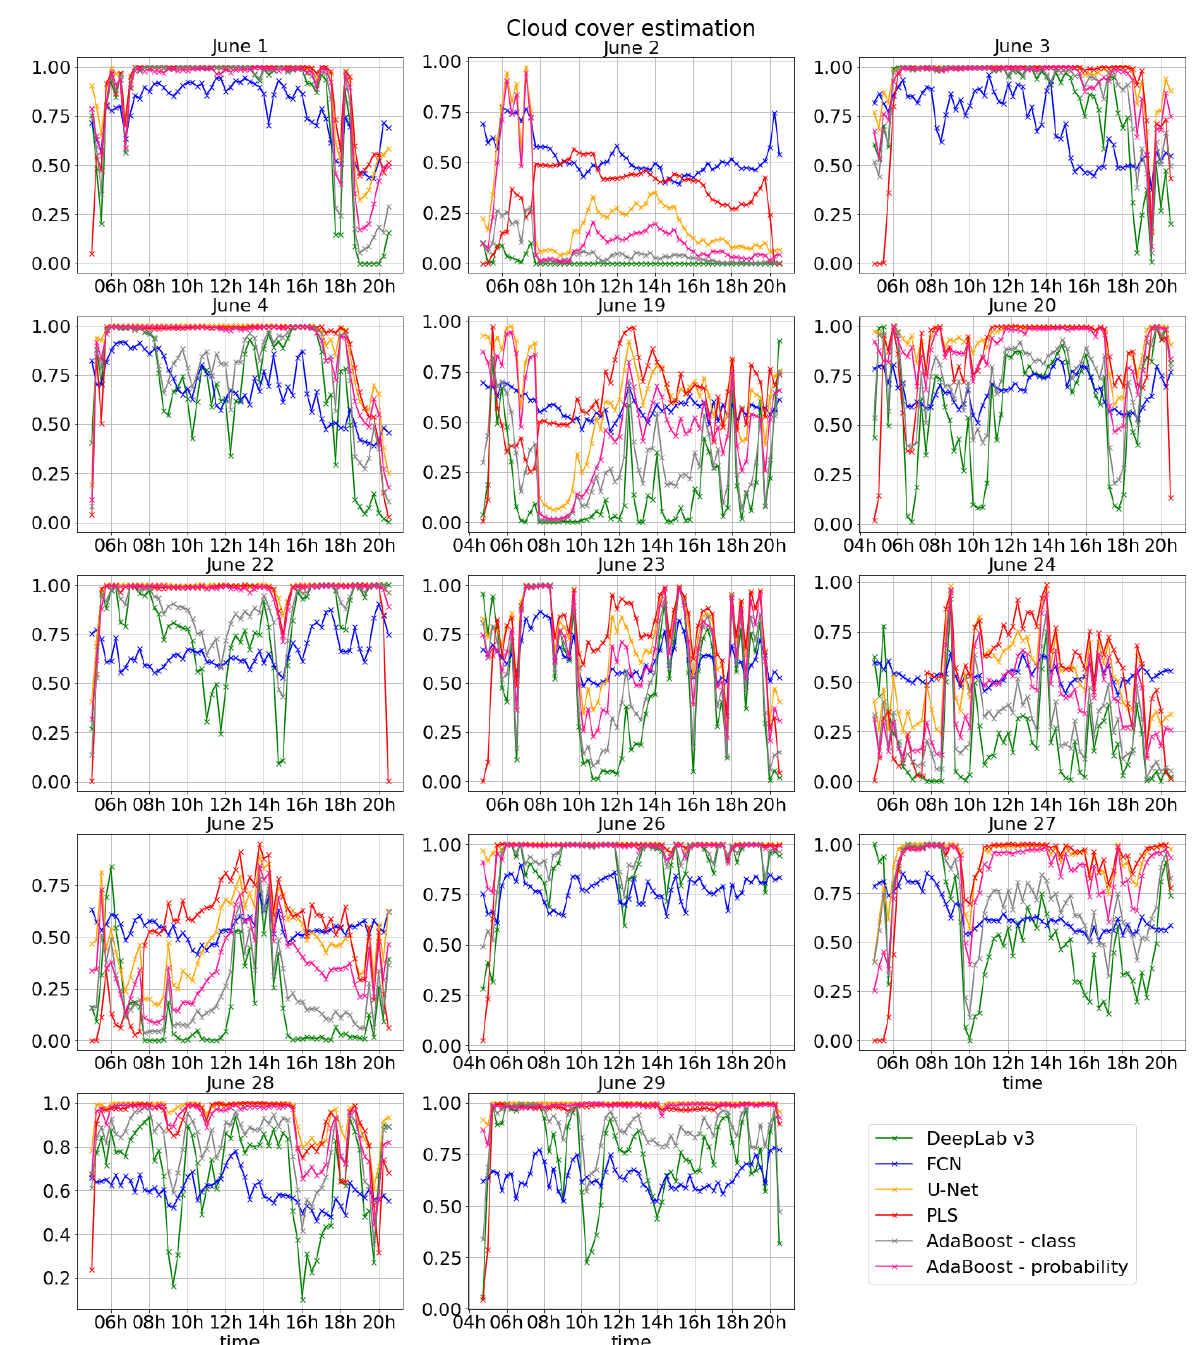
Figure A2. Results of 15 min-averaged cloud cover estimation for 14 days. The results show ratios of cloud pixels in images at each time point. If no cloud pixel was detected, the ratio was calculated as 0; if the whole sky was covered with cloud, the ratio was calculated as